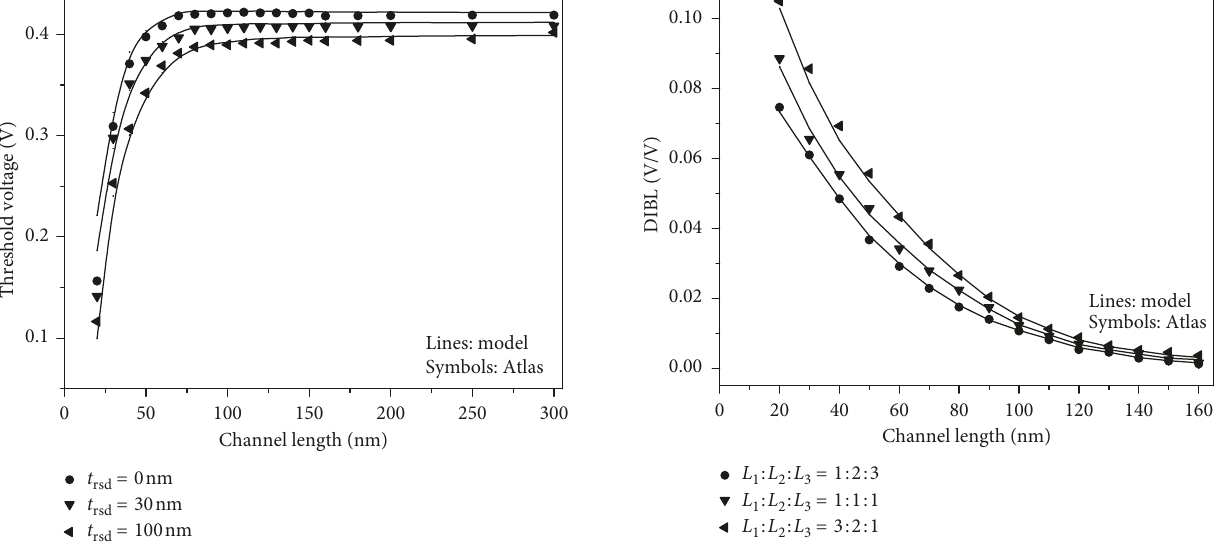
Figure 4: Threshold voltage for different values of recessed-source/ drain thickness.